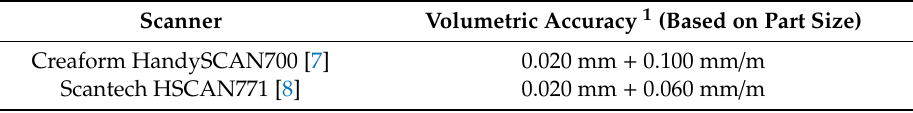
Table 1. Accuracy of the scanners involved in the comparison.